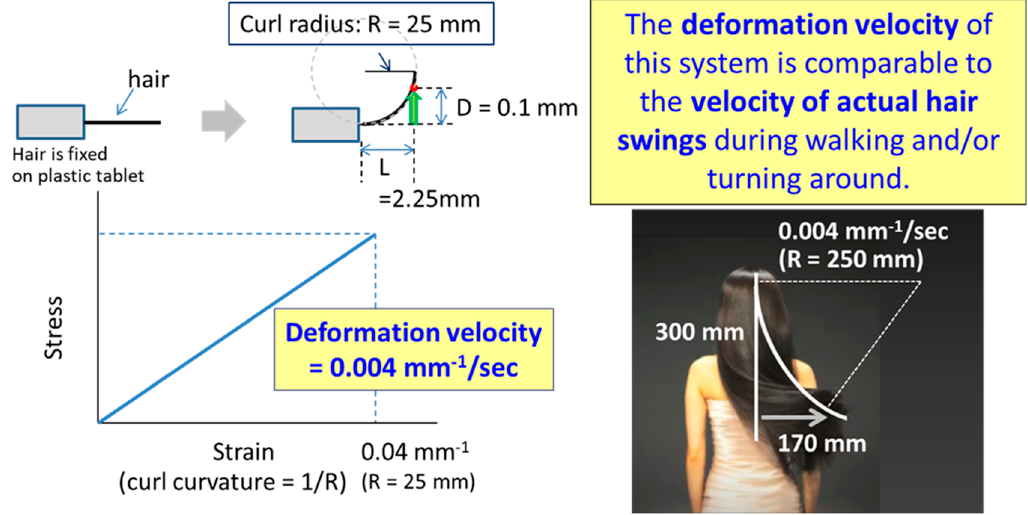
Figure 11. The deformation velocity at the measurement point and the deformation of the actual hair swing.